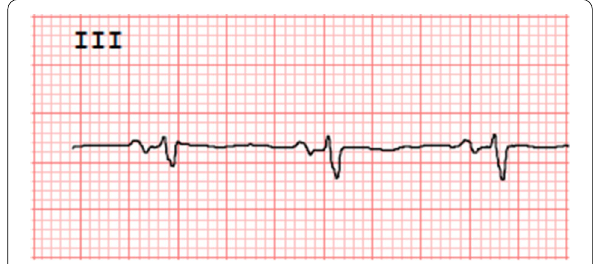
Fig. 1 Typical biphasic P waves in lead